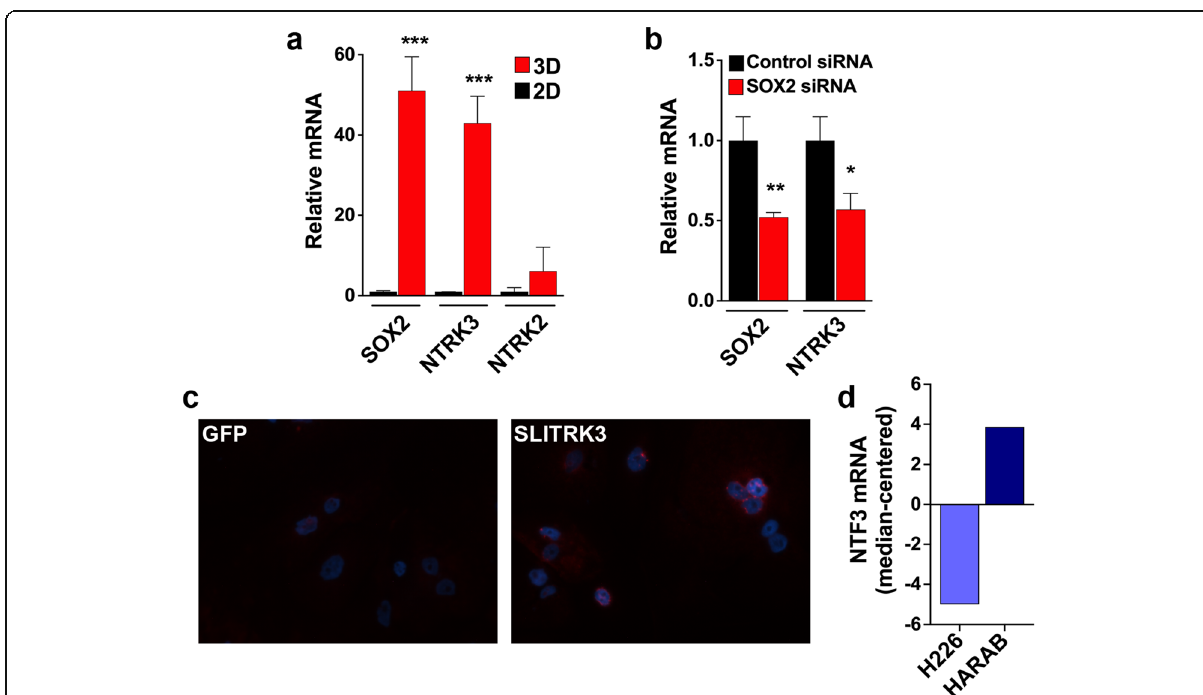
Fig. 3 NTRK3 expression is linked to CSCs, and SLITRK3 upregulates NTRK3 protein in LUSC cells. (a) Expression of NTRK3 and SOX2 in H226 sphere cultures (3D) relative to levels in H226 cells cultured under attached culture conditions (2D) according to qRT-PCR analysis. Bars, SEM. (b) Impact of SOX2-targeted siRNA treatment on SOX2 and NTRK3 expression levels relative to non-silencing siRNA control. The ON-TARGETplus siRNA pool targeting SOX2 was applied to H226 sphere cultures and levels were measured by qRT-PCR analysis. Bars, SEM. (c) In situ immunofluorescent detection of NTRK3 (red) in GFP-expressing H226 cells and in H226 cells stably overexpressing SLITRK3. Nuclei (blue) were stained with DAPI. (d) RNA-sequencing data (FPKM, log2, median-centered) displaying relative NTF3 mRNA levels in H226 and HARAB cells. * P <0.05, ** P <0.01, *** P